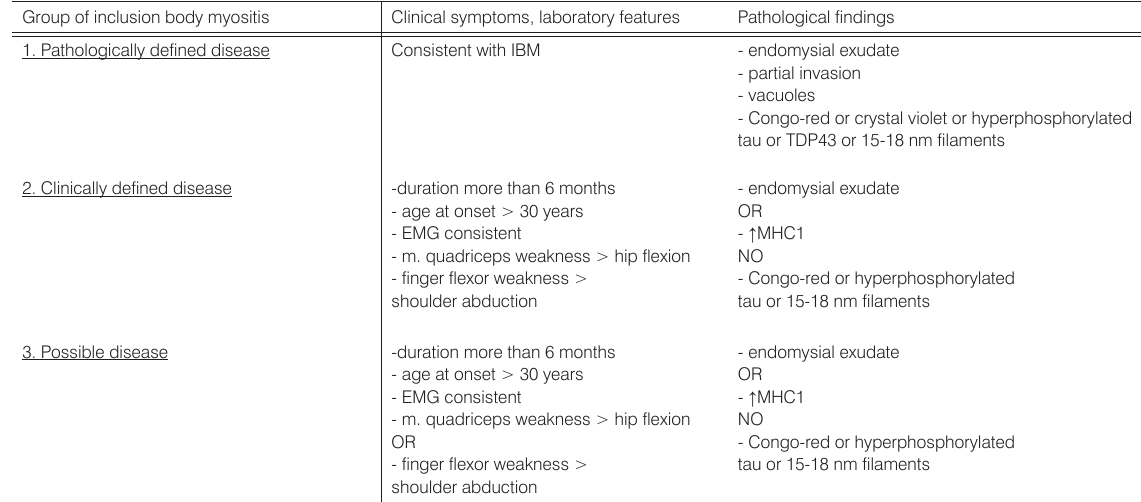
Table 1. Revised diagnostic criteria for IBM. (adapted from [ 2